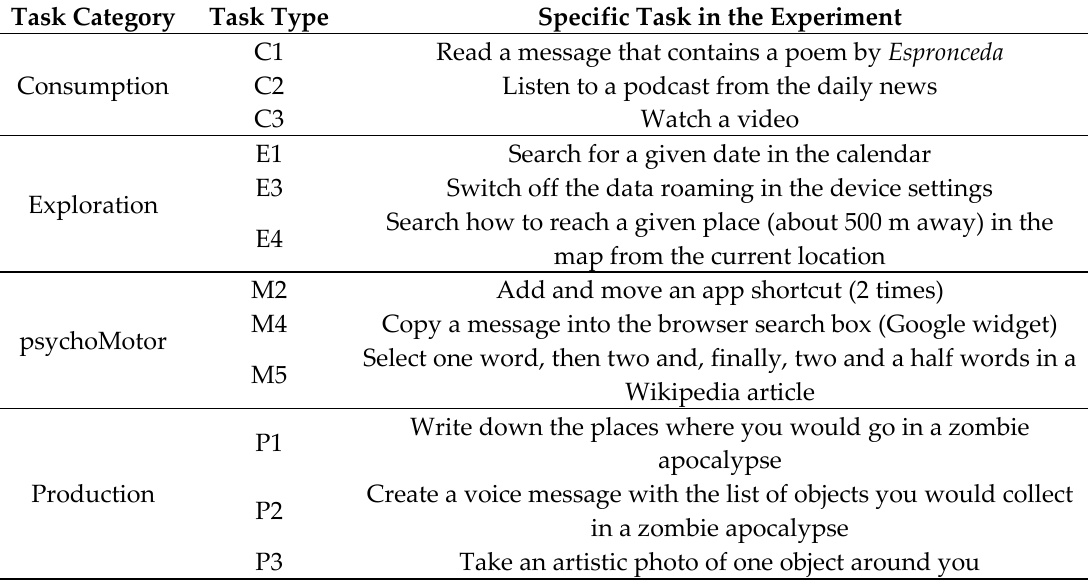
Table 2. List of tasks performed in the experiment according to HuSBIT-10